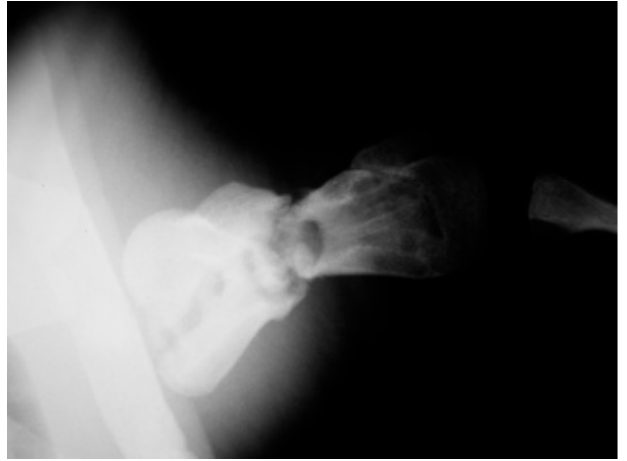
Figure 6. Radiographic examination at 12 months before ( a ) and after ( b ) removal of the synthesis methods (Caudocranial view): remodeling of fracture stumps, areas of thickened fibrous tissue, but still no appreciable unifying callus.